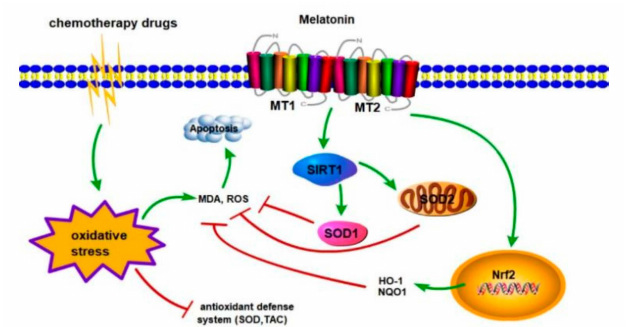
Figure 12. Schematic diagram illustrating the mechanism by which melatonin regulates the SIRT1/Nrf2 pathway through the melatonin receptors